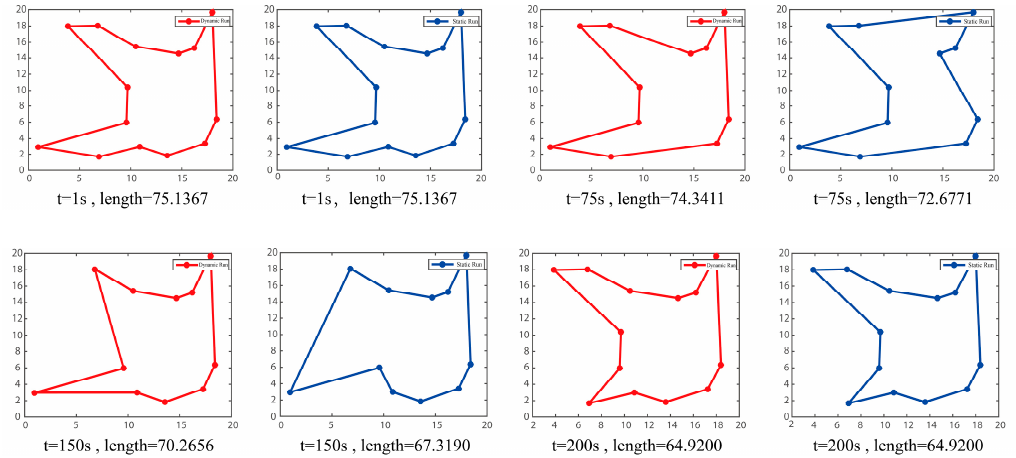
Figure 9. Optimal paths of both algorithms.